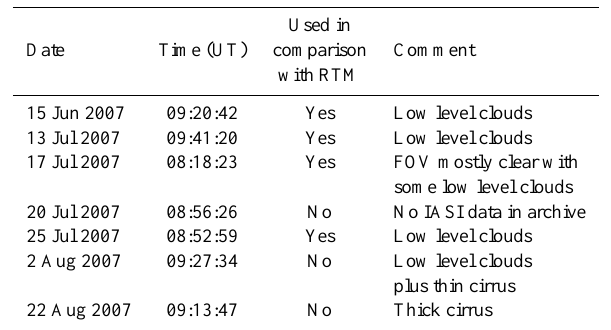
Table 1. Dates and times of IASI observations over Sodankyl¨a with co-located CFH sondes. Comments concerning cloud information have been obtained from visual inspection of AVHRR images.